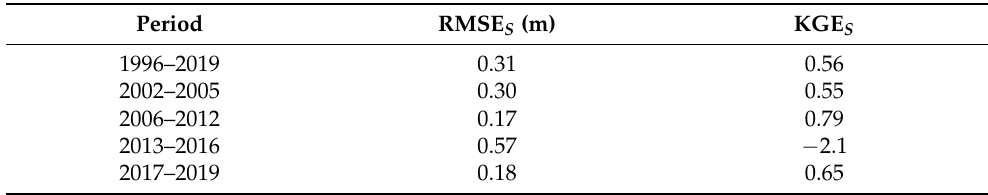
Table 4. Performance of the model simulating the monthly lake level, H : Root Mean Square Error, RMSE S , and Kling–Gupta efficiency, KGE S , in different